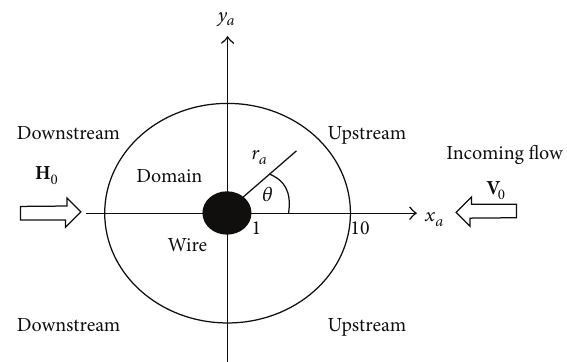
Figure 1: The simulation domain, direction of incoming fluid flow ( V 0 ), applied uniform magnetic field ( H 0 ), and the coordinates systems (not to